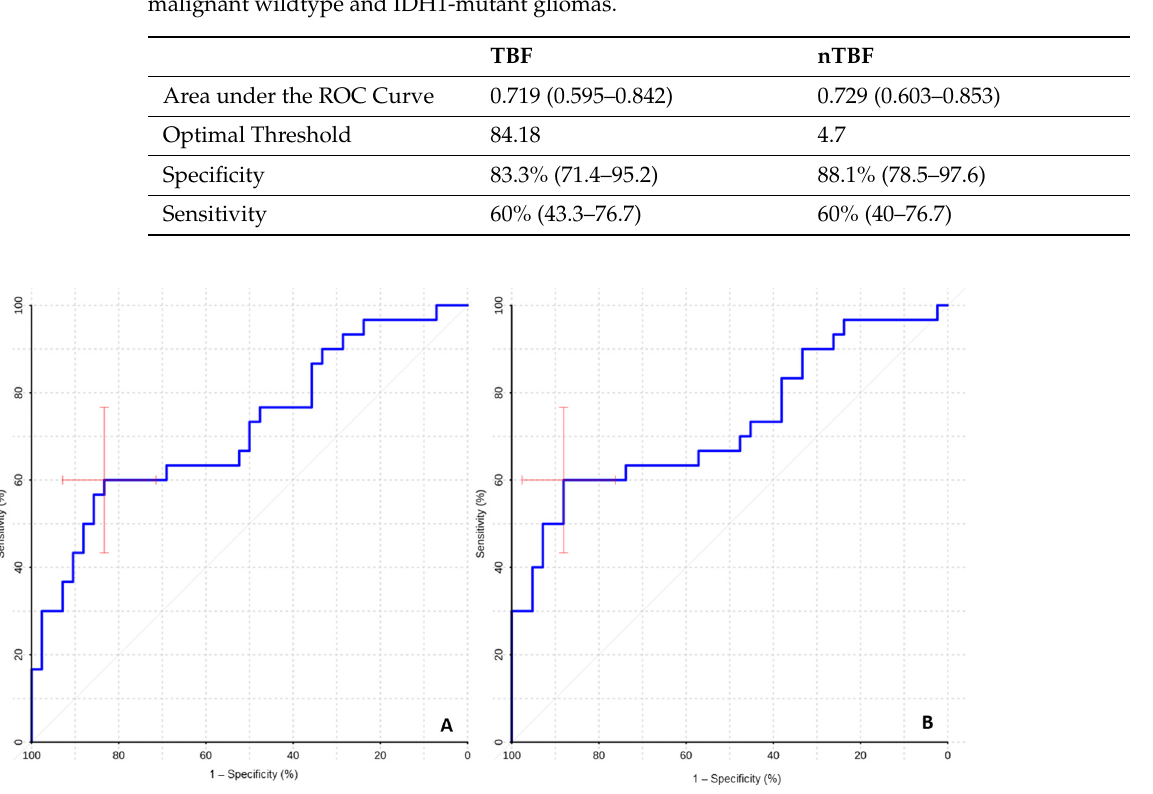
7 of 13 Figure 4. ROC curves. Comparison of maximum blood flow ( A ) and maximum normalized blood flow ( B ) between groups of wildtype and IDH1-mutant gliomas. High AUC values in the ROC-analysis (0.783 for TBF and 0.791 for nTBF) indicate that ASL perfusion might be useful/informative in the differential diagnosis of gliomas with different IDH1 status.